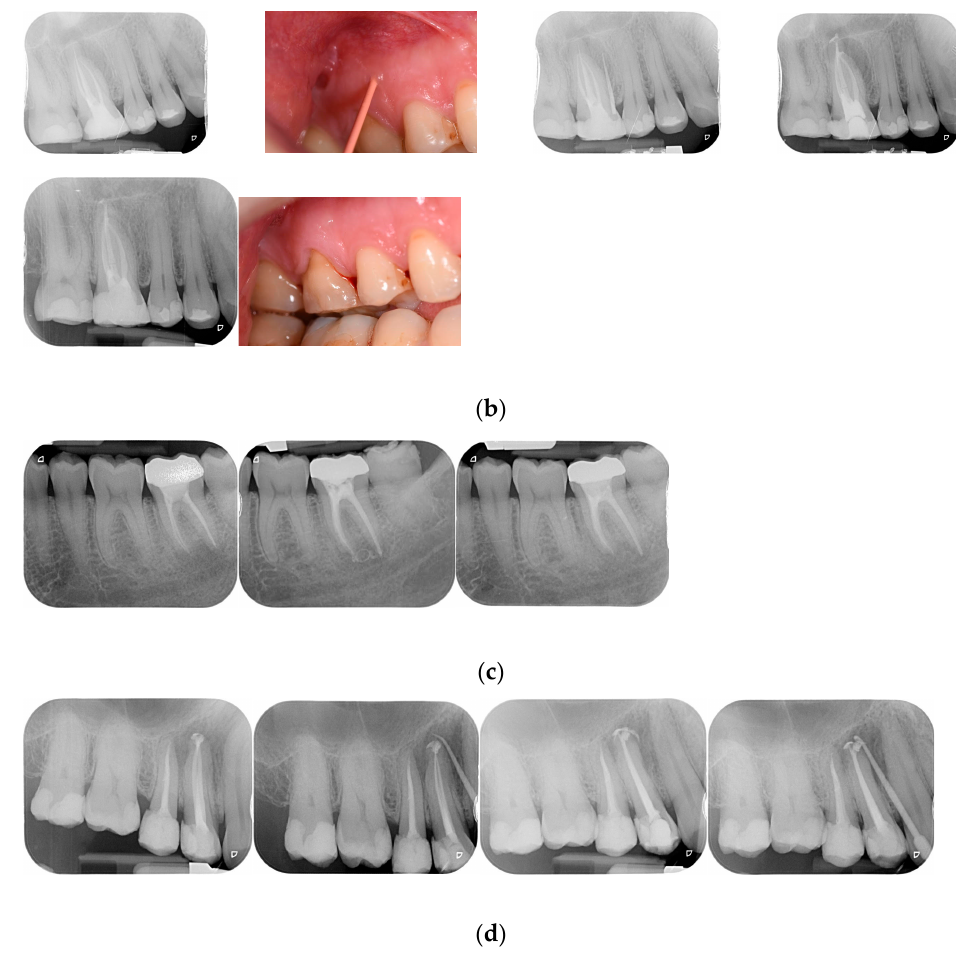
Figure 1. ( a ) Healed lower incisor at 12 months recall. ( b ) Healed upper first molar at 18 months recall. ( c ) A lower second molar in healing process after 6 months. ( d ) Not healed first upper bicuspid at 8 months recall.